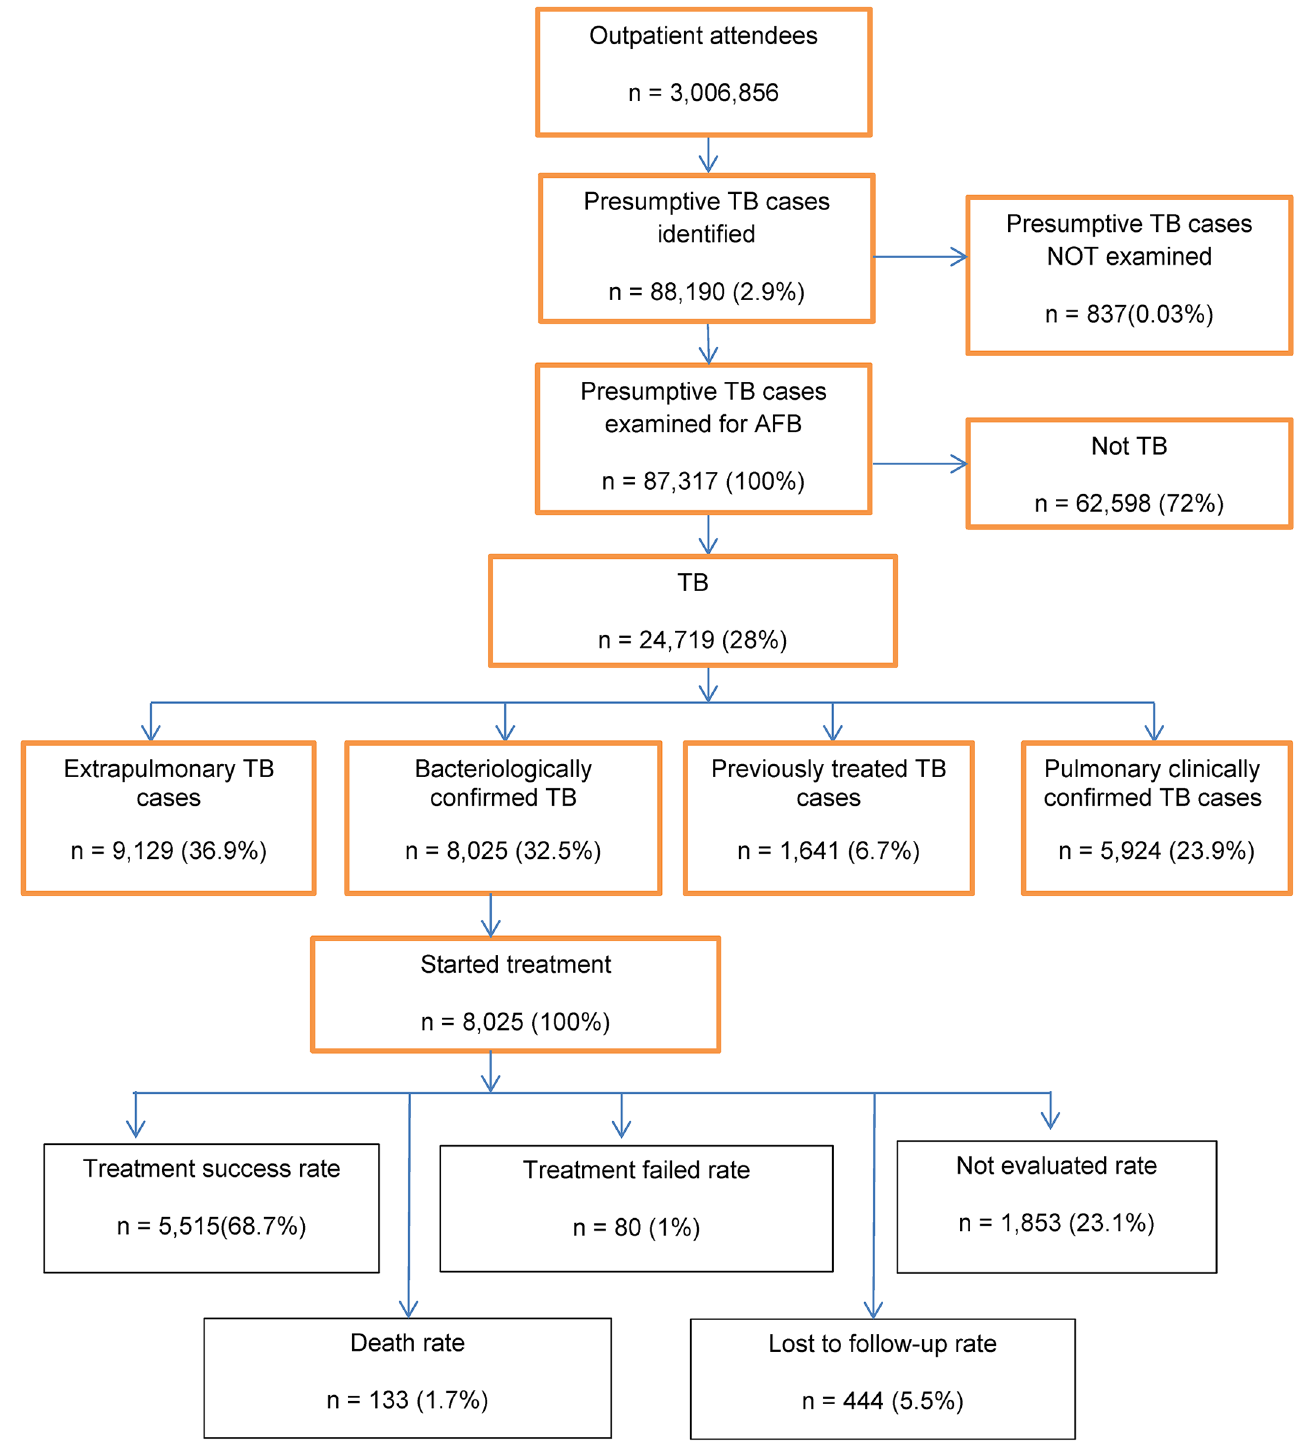
Fig 2. Flow chart of TB casenotification and treatment outcomes in Kabul, 2009–2015.